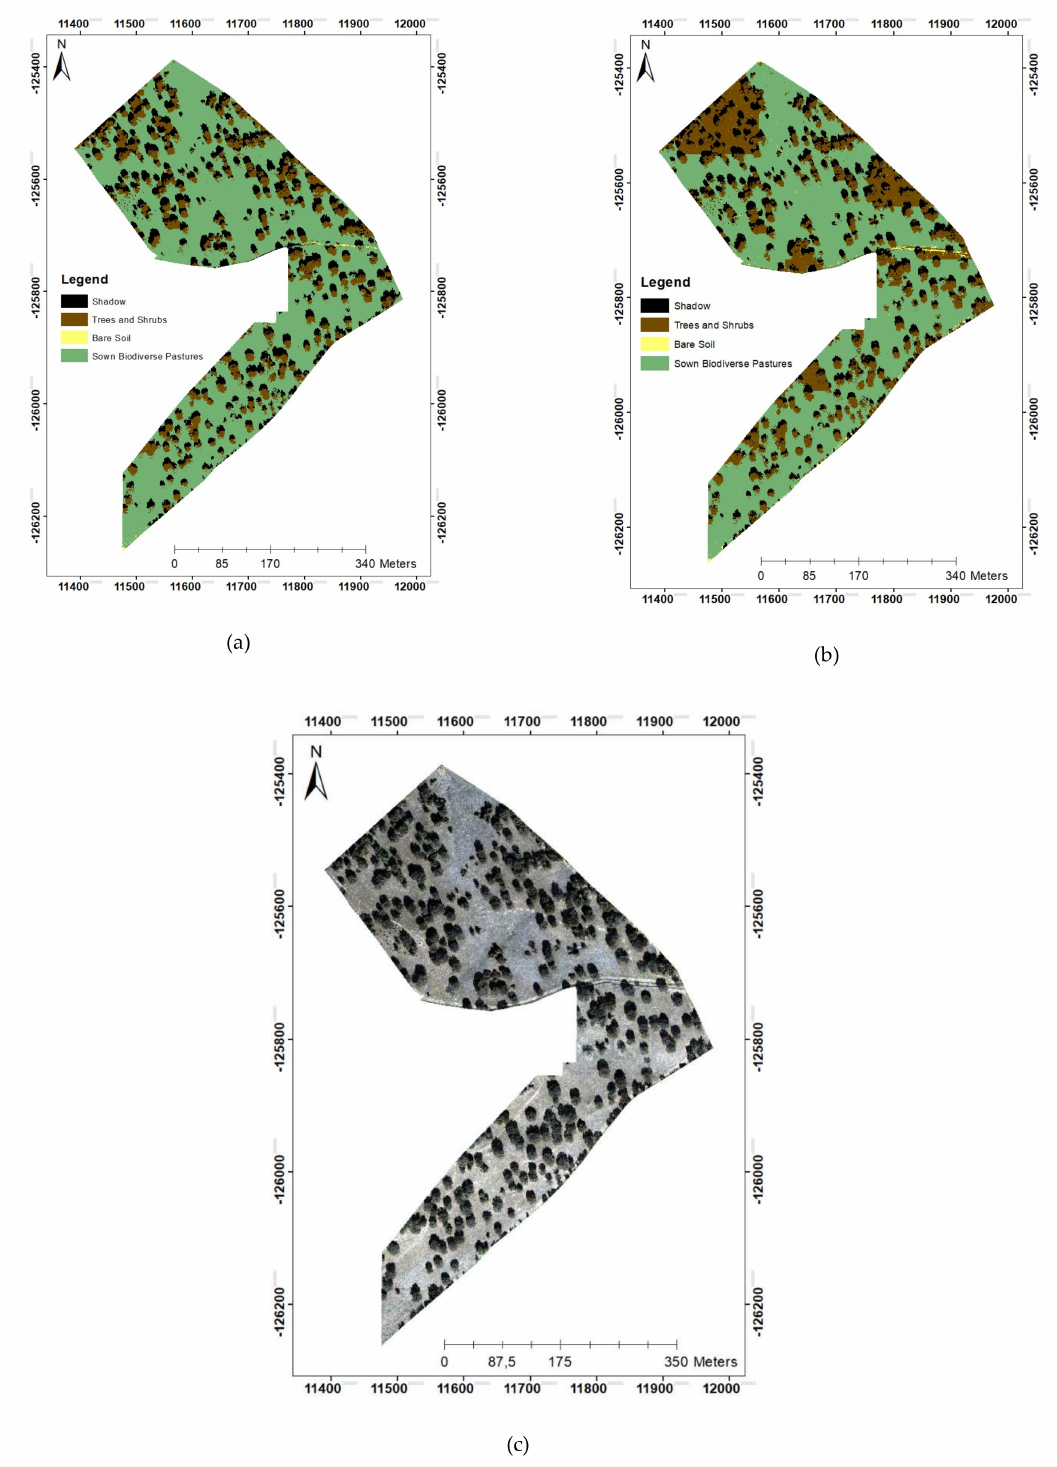
Figure A2. Land cover maps produced through single epoch classification using Support Vector Machines ( a ) and Artificial Neural Networks ( b ) for farm 3, as well as an aerial photograph of farm 3 acquired in the 10th of November, 2017 ( c